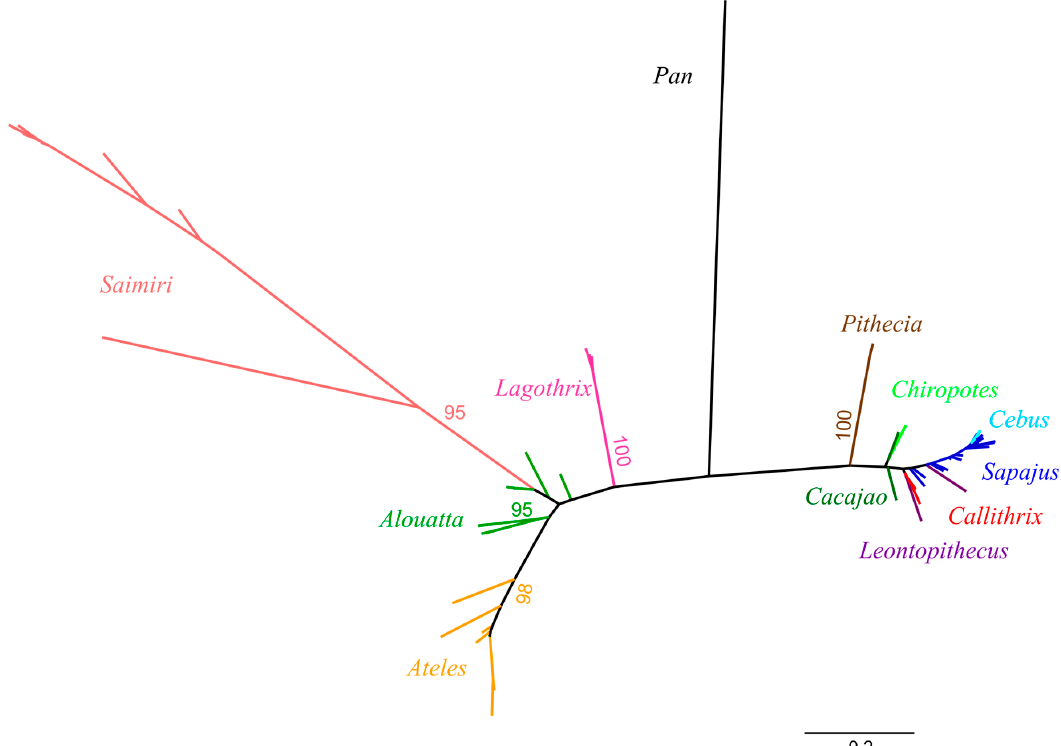
Figure 2. Phylogenetic relationships of simian foamy viruses from neotropical primates (NPs). Unrooted tree inferred by maximum likelihood analysis of an alignment of 411 nucleotides of partial polymerase sequences with 1000 bootstrap replicates. Different NP genera and bootstrap values are indicated by distinct colors. Distance bar is shown at the bottom.